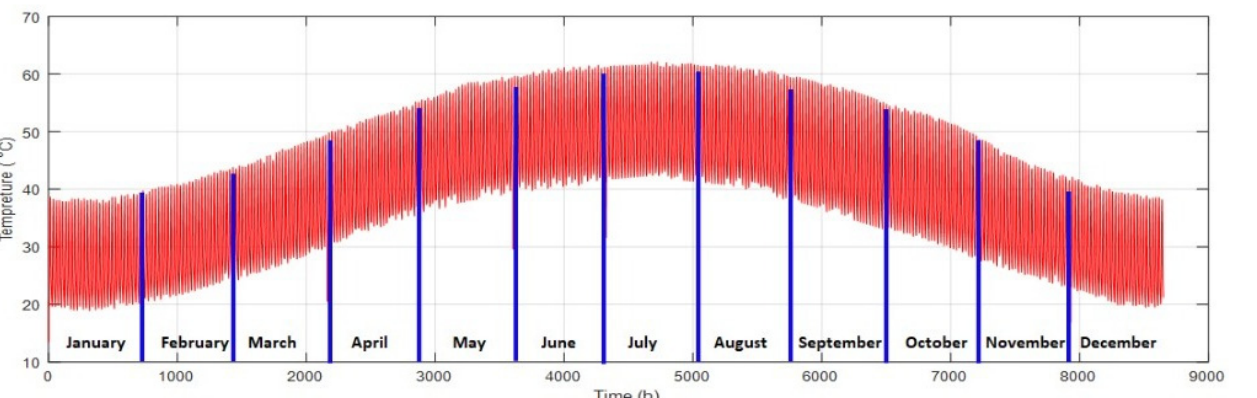
Figure 18. The temperature distribution of the SHC through ( a ) morning, ( b ) zenith, ( c ) afternoon, and ( d ) night.